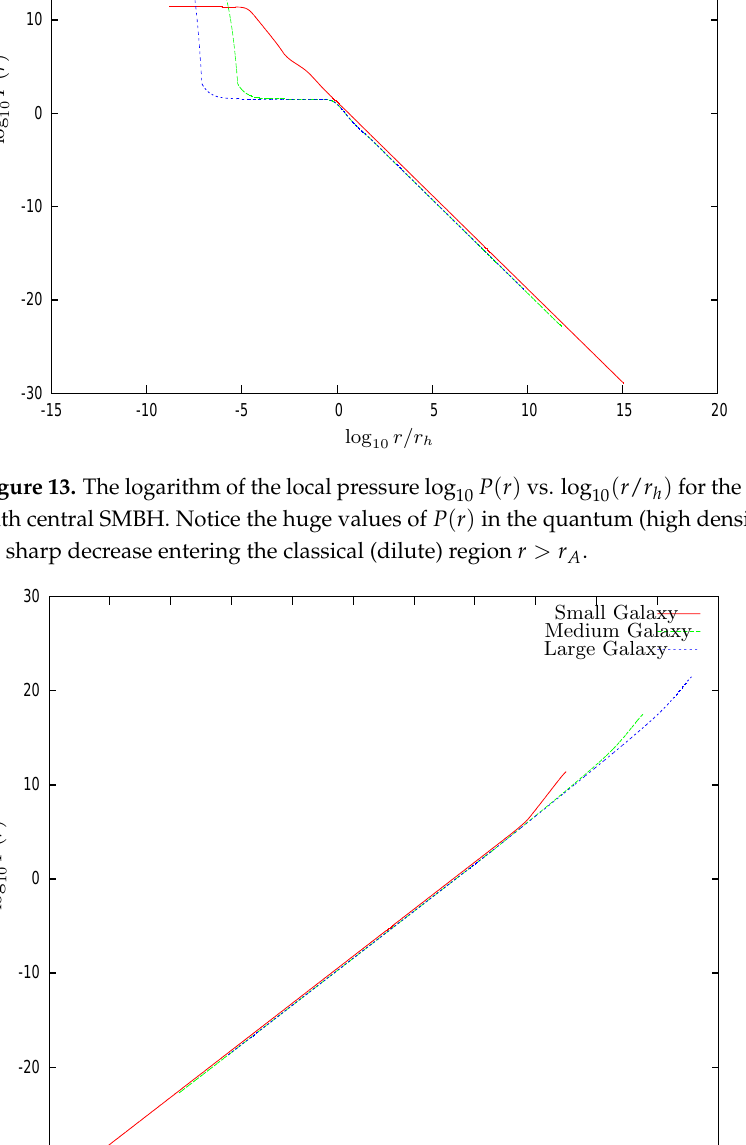
FIG. 14: The obtained equation of state of the galaxy plus central SMBH system: The logarithm of the local pressure log vs. log ρ ( r ) /ρ 0 . In all the cases we find almost straight lines of unit slope. The equation of state is a perfect gas equation 10 of state in the Boltzmann classical region. In the quantum gas (dense) region the equation of state becomes steeper than the perfect gas. Galaxies with central black holes are in the dilute Boltzmann regime because their halo masses are M h > M min h eq.(4.2). This explains the perfect gas equation of